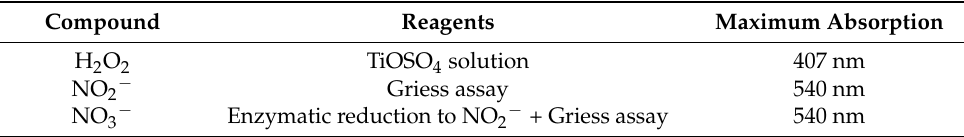
Table 2. Conditions for colorimetric method.